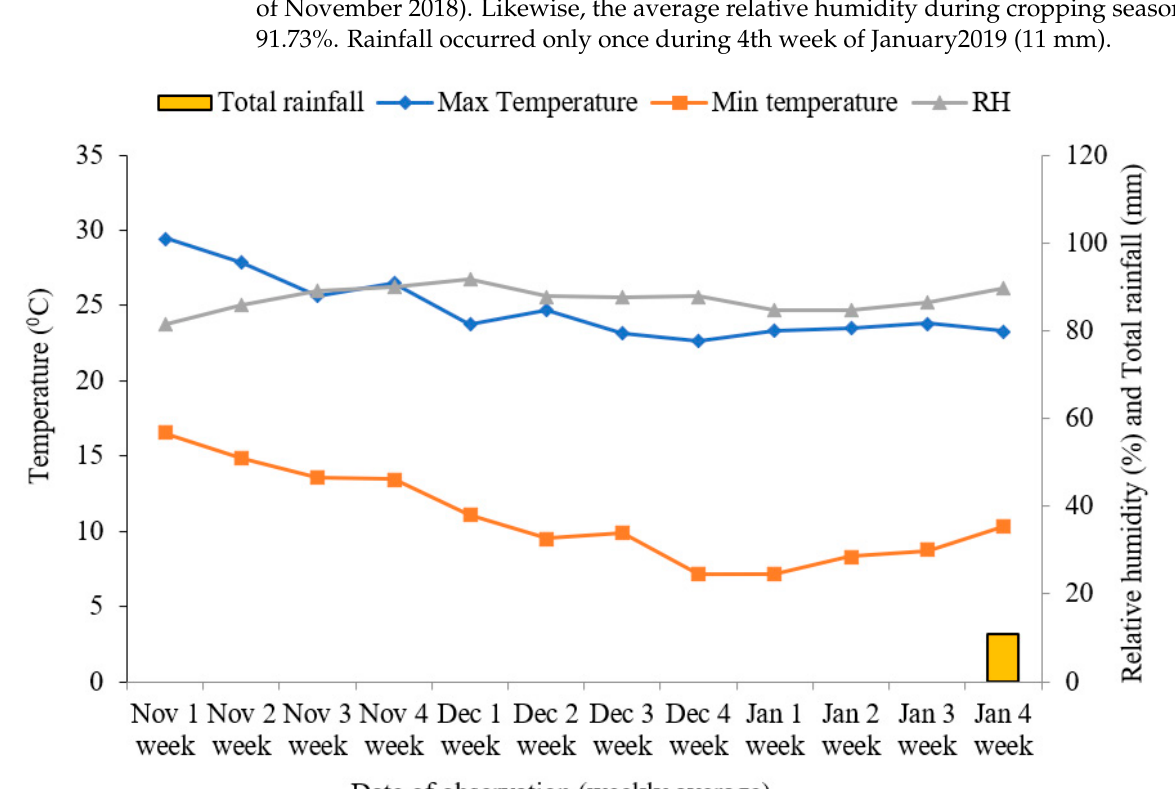
Figure 1. The weekly average meteorological data of the experimental site (Horticulture farm, AFU, Rampur, Chitwan from November 2018 to January 2019.